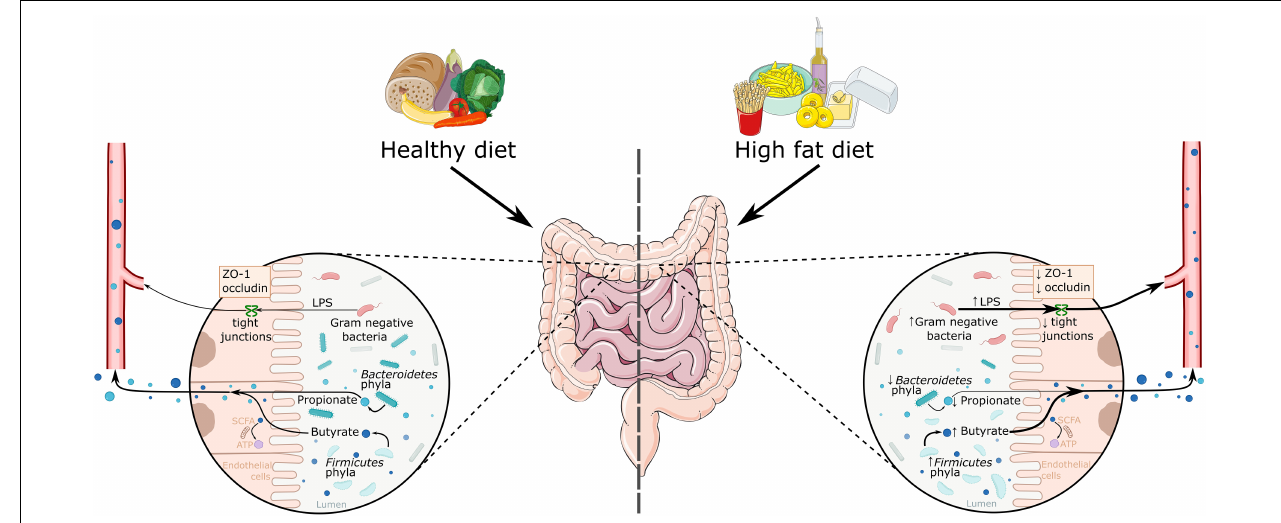
FIGURE 1 | A schematic overview of the effects of a high fat diet on the gut microbiome. High fat diet is associated with increased Firmicutes phyla and decreased Bacteroidetes phyla abundance. This leads to a change in the produced metabolites, as there is an increase in butyrate and a decrease in propionate levels. High fat diets are also associated with increased Gram-negative bacteria, which activate the immune system via LPS. This LPS can enter the bloodstream through decreased gut permeability, as seen in decreased levels of tight junction proteins zonulin-1 and occludin. ATP, adenosine triphosphate; LPS, lipopolysaccharide; SCFA, short chain fatty acids; ZO-1,